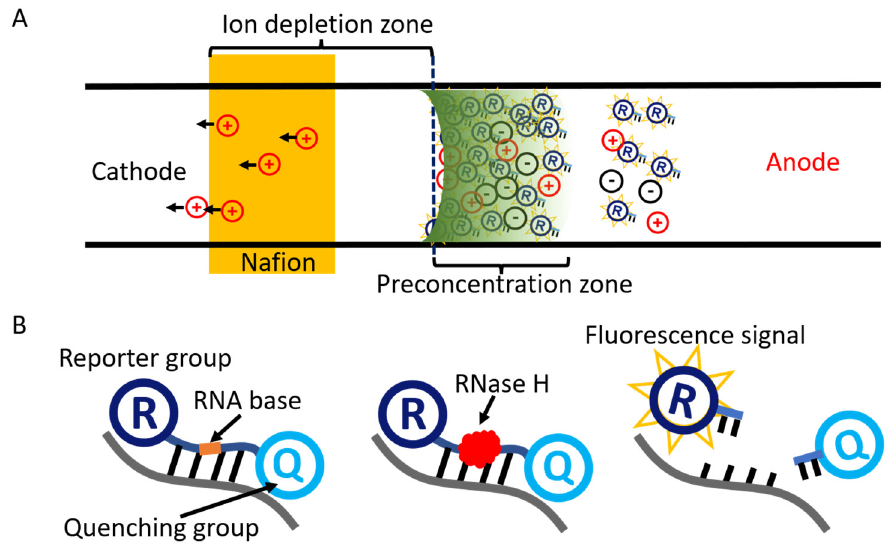
Figure 1. ( A ) Principle of ion concentration polarization. Negatively charged molecules are enriched to the preconcentration zone by the electric field and electro-osmotic flow. ( B ) Schematic of the cycling probe method. The fluorescent reporter group leaves the quenching group in the presence of endonuclease RNase H to emit a fluorescent signal.